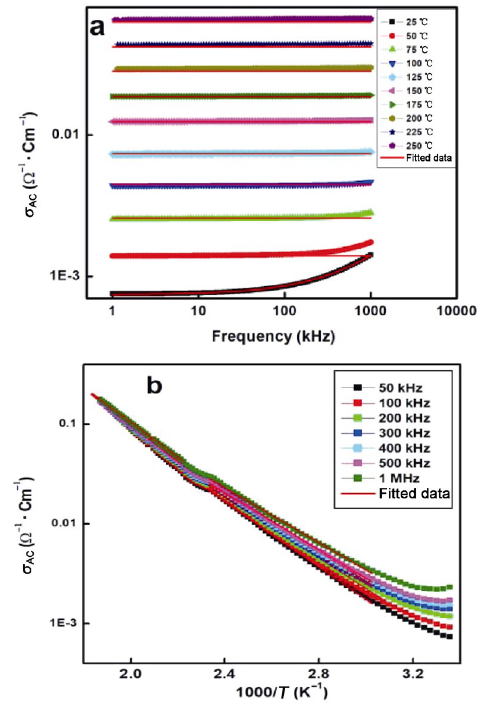
Fig. 7 Variation of AC conductivity with (a) frequency at selected temperatures and (b) inverse of absolute